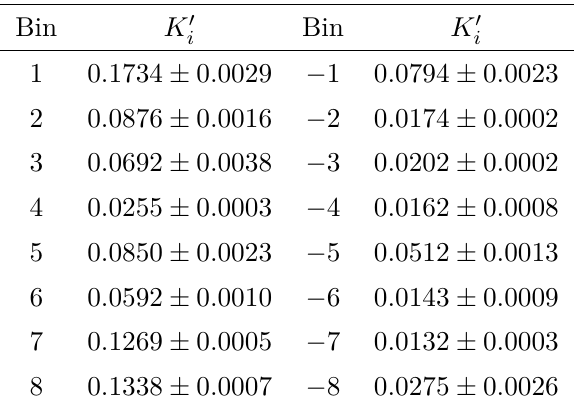
parameters as calculated from the model of ref. [45], equivalent to the fraction Table 7 . The K 0 i of flavour-tagged D → K 0 π + π − decays falling in each bin of the Dalitz plot, including D 0 - S oscillation effects, in the equal- ∆ δ binning scheme. D